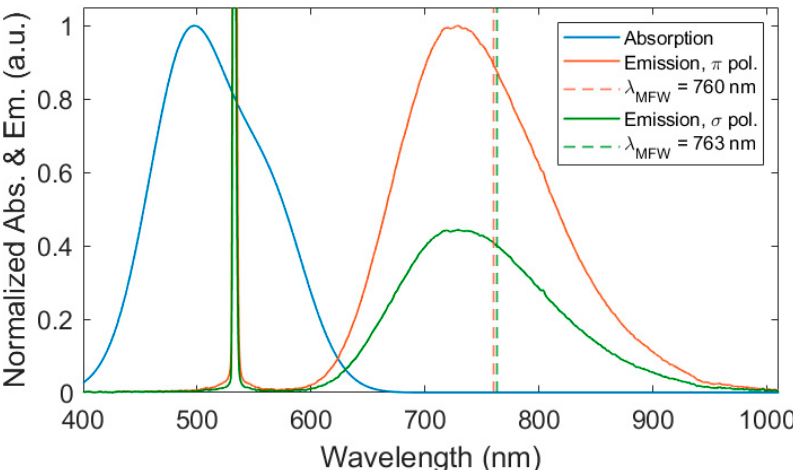
Figure 13. Normalized absorption (blue), 𝜋 -polarized emission (orange), and 𝜎 -polarized emission (green) spectra of Ti 3+ :Al 2 O 3 (GTAT sample). Dashed vertical lines indicate the calculated mean fluorescent wavelengths (MFW) for emission spectra.